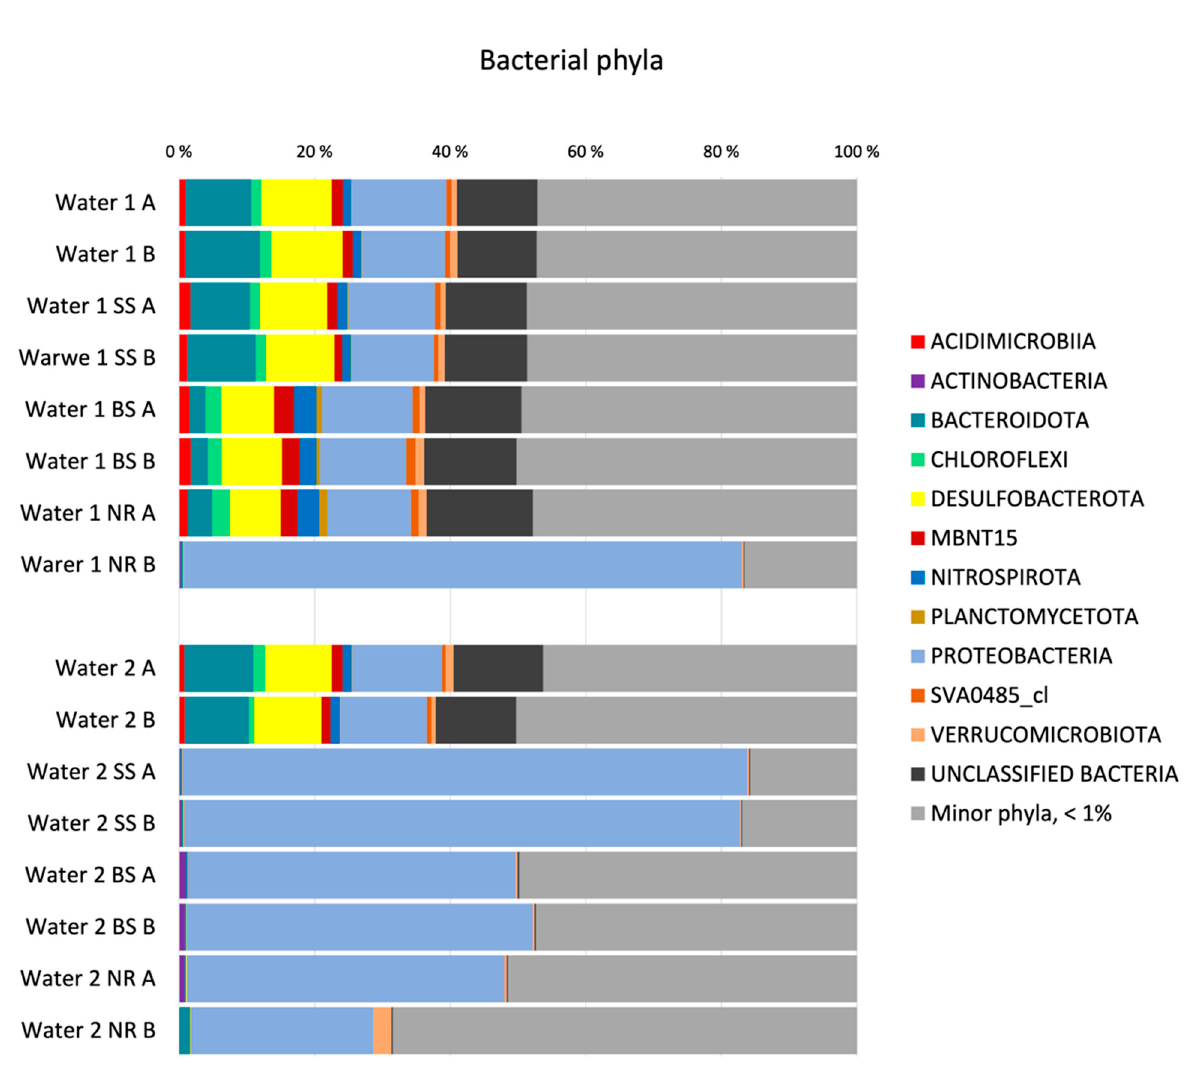
Figure 2. The relative abundance of bacterial phyla in the mine water and microcosm waters incubated for 18 weeks. The combined relative abundance of minor genera that each contributed with less than 1% of the bacterial communities are collected under Minor phyla, <1%. SS, BS and NR indicate microcosms containing sandstone, black shale and no rock, respectively, and A and B indicate replicate microcosms.